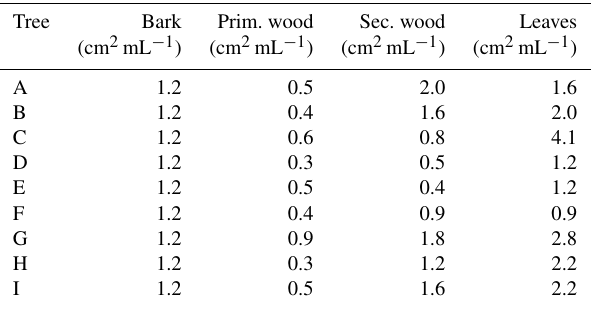
Table 3. Surface area per millilitre of extracted water (ultra-pure) for bark, primary and secondary wood, and leaf